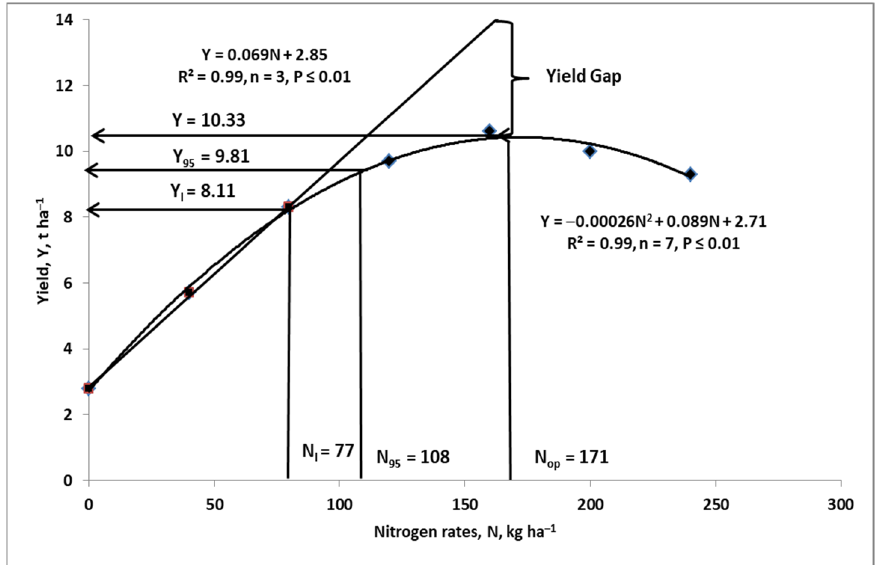
Figure 5. The nitrogen fertilizer rates calculated for the three models of winter wheat yield response to increase its rates. Based on Szczepaniak [148]. Legend: response functions: N l —linear, b. N 95 —quadratic—assumed yield reduction to 95% of its maximum, c. quadratic basic for the set of N f rates—N op .